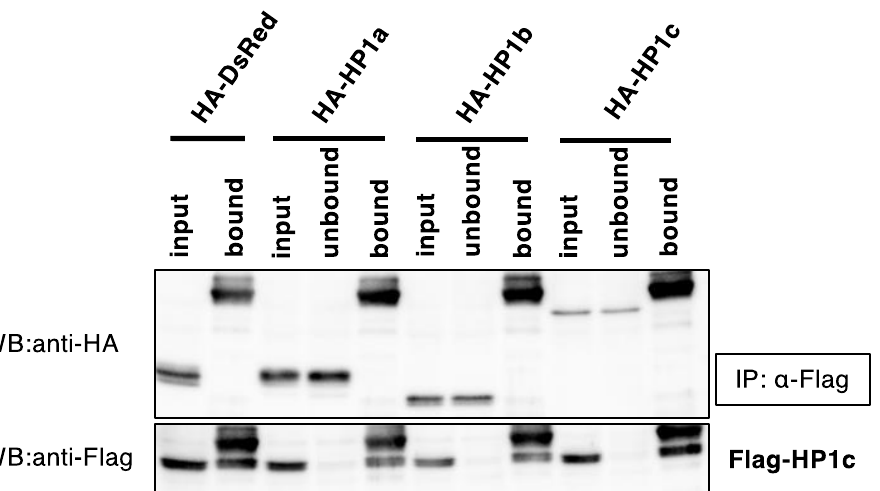
Figure 3. Co-immunoprecipitation of BmHP1c and BmHP1 s. Flag-BmHP1c and HA- BmHP1 s ex- pression plasmids were co-transfected into BmN4 cells, and 5 days later, the cells were collected and co-immunoprecipitation was performed. Input samples are cell lysates, unbound samples are samples that did not bind to the antibody-coupled G protein beads, and bound samples are bound to antibody-coupled G protein